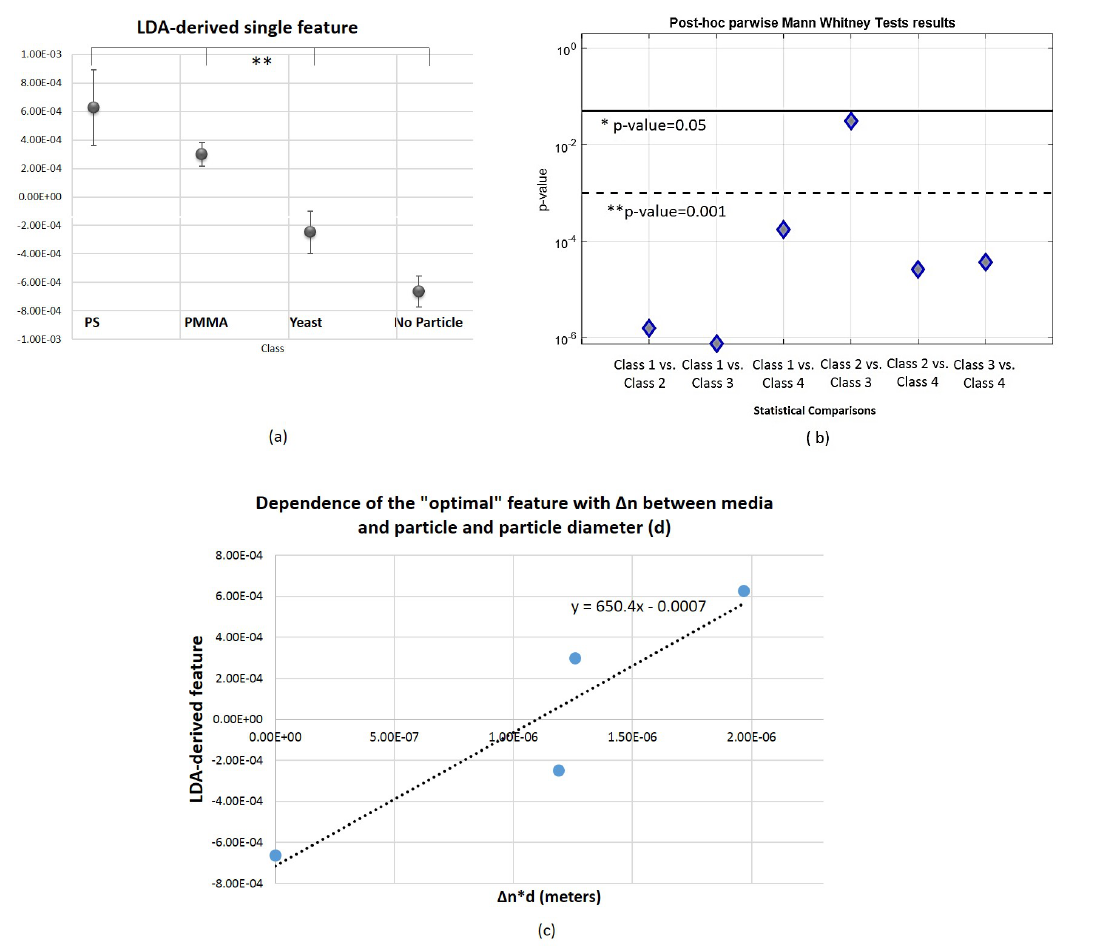
Figure 14. Statistical comparison between 4 classes and post-hoc parwise results for the obtained LDA-derived single feature and its dependence with ∆ n between media and each particle; and particle diameter (d). ( a ) Results of the Kruskal-Wallis test. Vertical axis is in logarithmic scale. ** p < 0.001. * p < 0.05. ( b ) Graphical representation of p -values obtained in the post-hoc parwise analysis using the Mann Whitney test. Vertical axis is in logarithmic scale. ** p < 0.001. * p < 0.05. ( c ) LDA-derived feature versus ∆ n · d , in which d is the particle diameter in meters, and corresponding fit line. Spearman correlation results (two-tailed): r Spearman = 1.00; p Spearman <